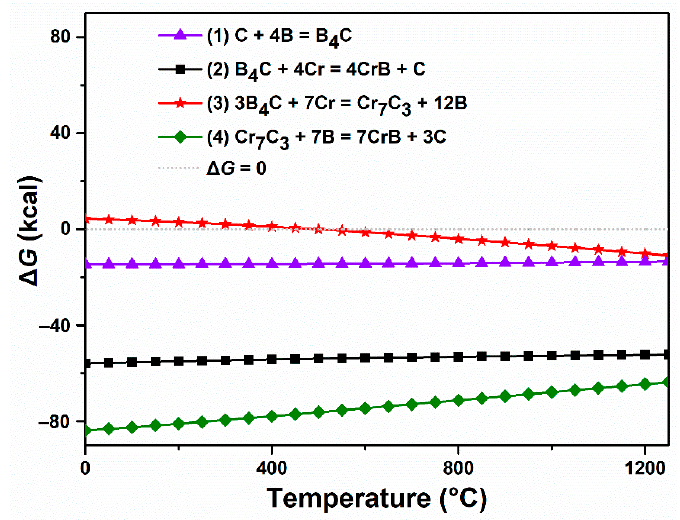
Figure 3. Relationships of temperature on Gibbs free energy ( Δ G ) of the reactions (1)–(4).